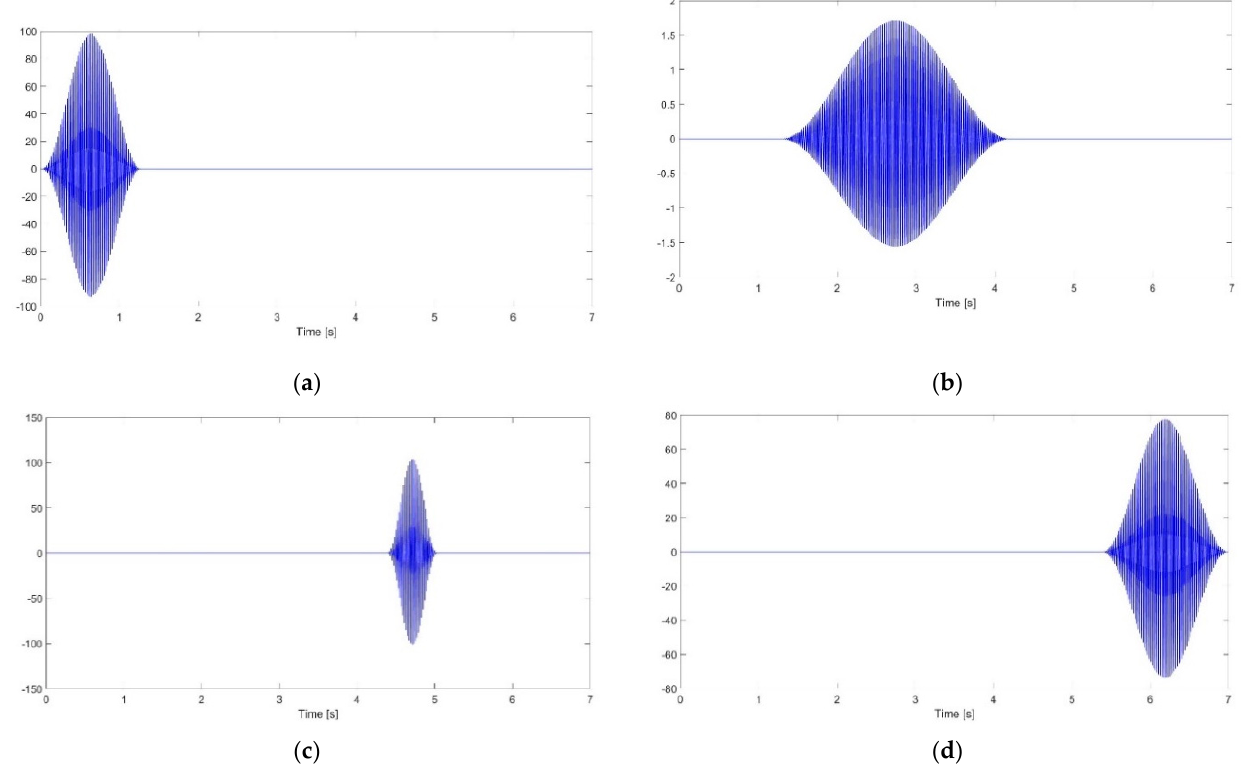
Figure 8. Quasi-steady-state intervals enhanced with Hanning windows: ( a ) First interval, ( b ) second interval, ( c ) third interval subjected to EMD for a second time, ( d ) fourth interval.